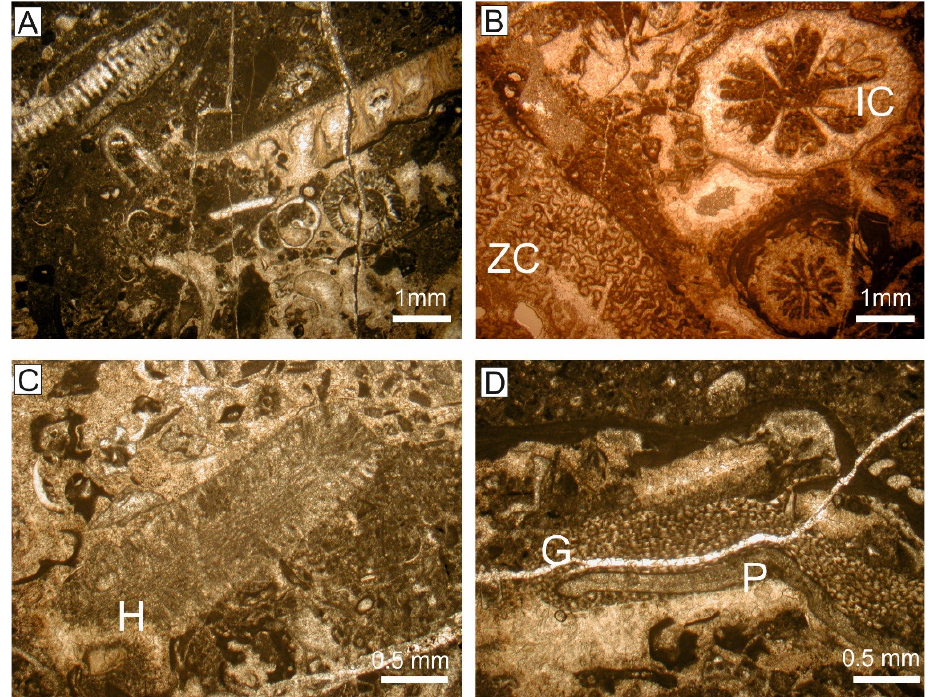
Figure 5. ( A ) Dasycladaleans are common components in the mud-supported matrix of coral mounds; ( B ) detail of coral framestone of mound including z-corals (ZC) and isolated corals (C); ( C ) the green algae assemblage of the coral mound includes also halimedaceans (H); ( D ) different encrusting biota characterize the coral mound, between these encrusting foraminifers ( Gypsina ) (G) formed a hooked form developing on peyssonnelliaceans (P).